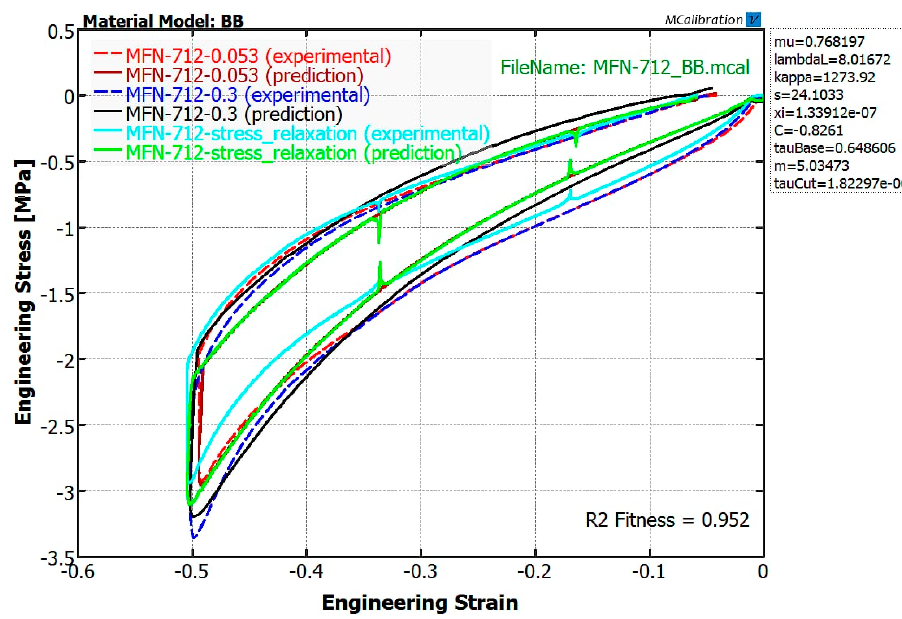
Figure 4. Result of curve fitting for the B-712 compound with Bergström-Boyce constitutive model.